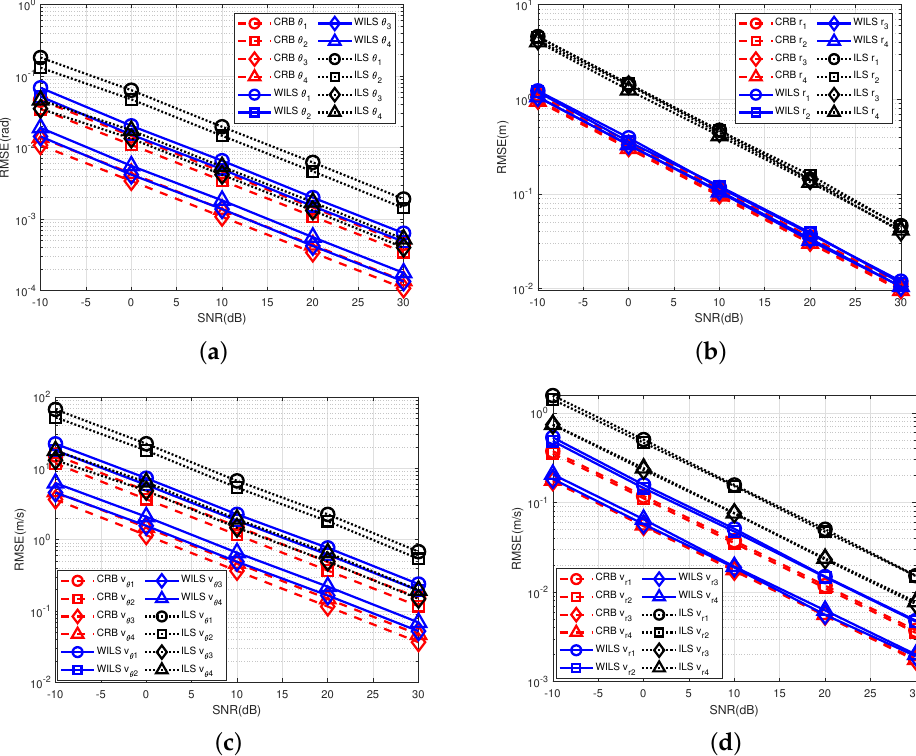
Figure 9. Estimation results for different methods in the presence of different SNRs in different prop- agation paths ( a ) RMSE for the DOA estimation, ( b ) RMSE for the target range estimation, ( c ) RMSE for the target tangential velocity estimation, ( d ) RMSE for the target radial velocity